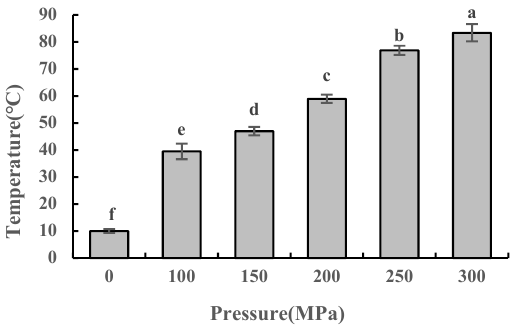
Figure 1. Sampling temperature of skimmed milk under different pressure conditions. Different superscript letters within a column indicate significant differences between means ( p < 0.05).